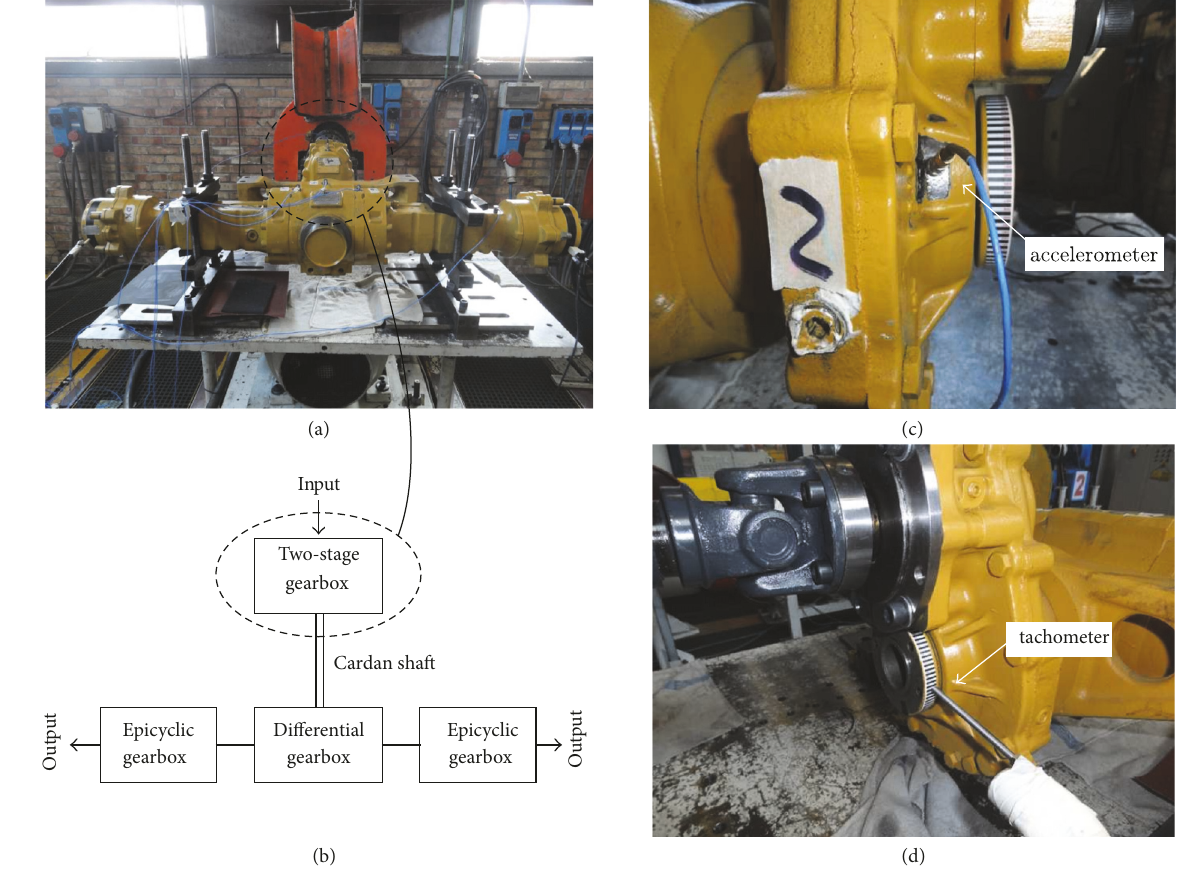
Figure 17: Experimental setup of Case 1: (a) transmission system on the test bench, (b) schematic of the transmission, (c) accelerometer, and (d) tacho probe with zebra tape.